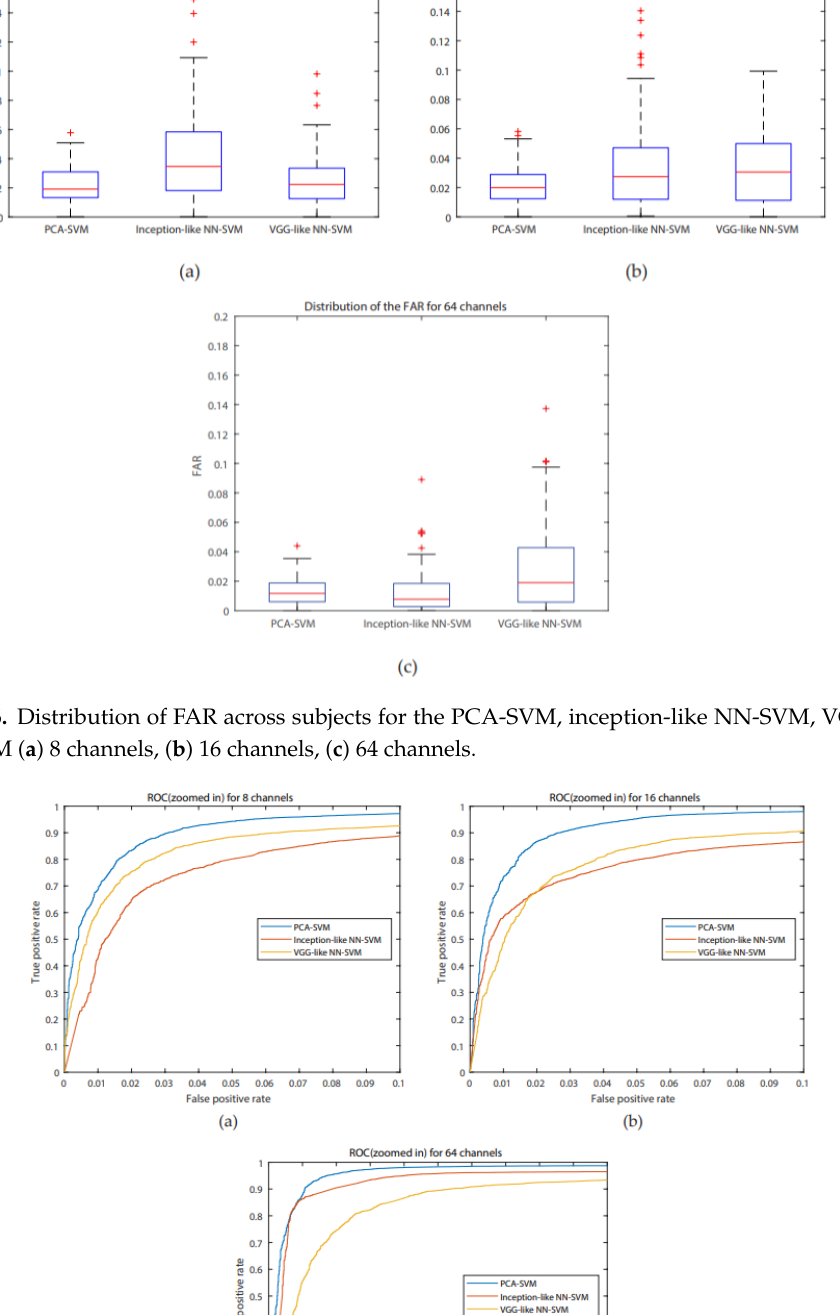
Figure 8. Distribution of FAR across subjects for 8, 16, and 64 channels for the ( a ) PCA ‐ SVM, ( b ) inception ‐ like NN ‐ SVM, and ( c ) VGG ‐ like NN ‐ SVM.